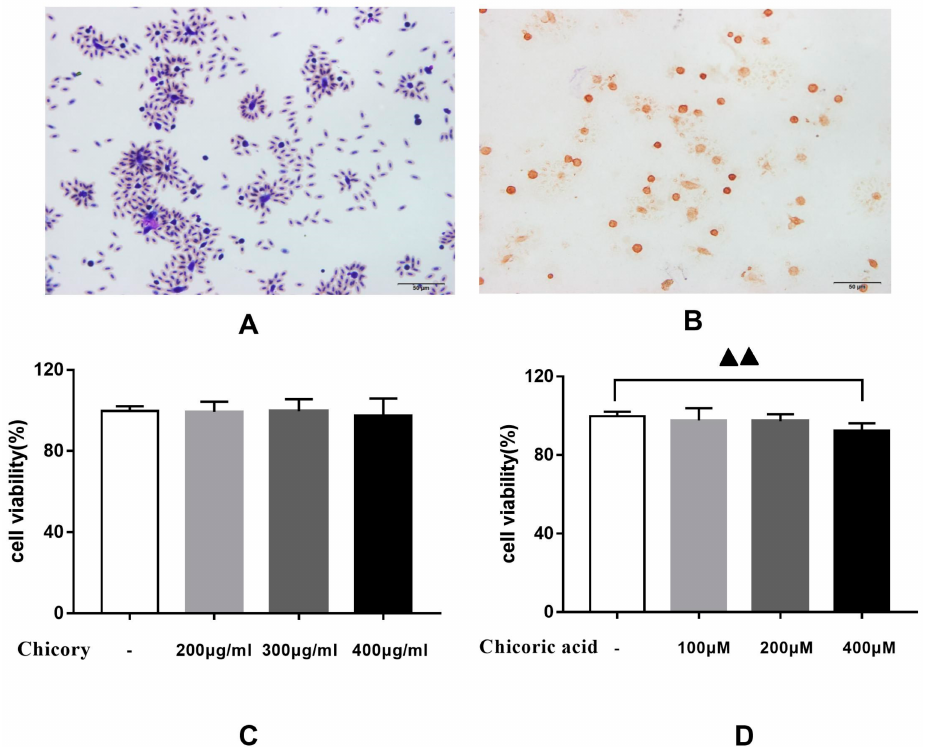
Figure 5. Proliferation ability of macrophages stimulated with various concentrations of chicory extract and chicoric acid: ( A ) Phagocytic function of macrophages, ( B ) CD68 staining in macrophages, ( C ) macrophages stimulated with chicory extract, and ( D ) macrophages stimulated with chicoric acid. Data are expressed as mean ± SD for three repetitions in each group. (cid:78)(cid:78) p < 0.01 vs. non-treated